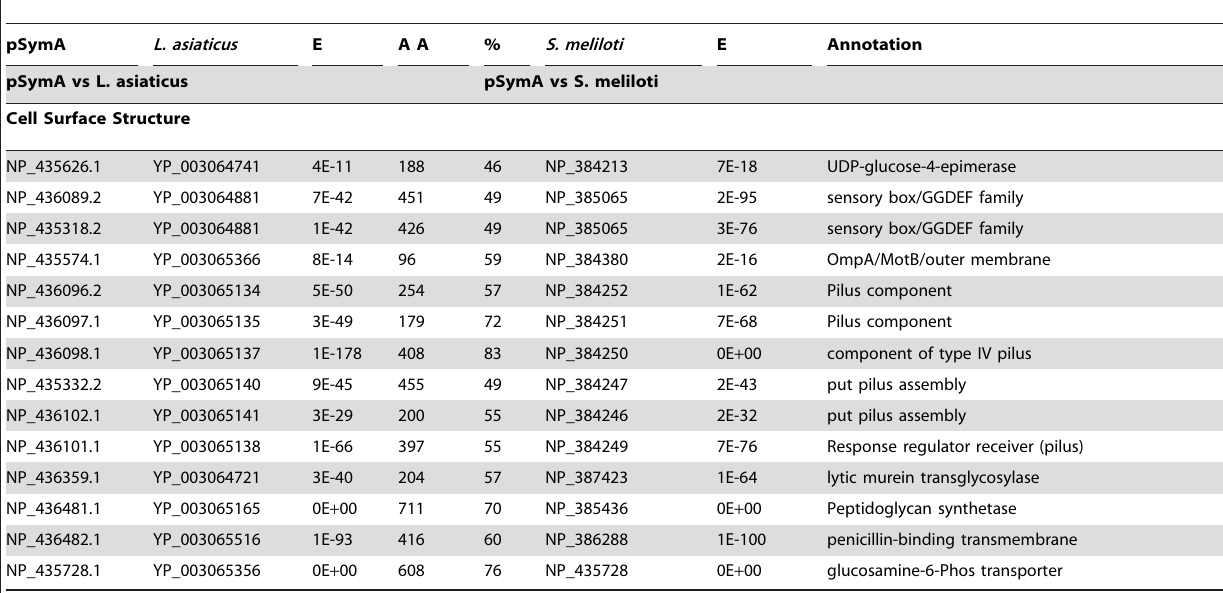
Table 4. Proteins shared between the Sinorhizobium meliloti plasmid pSymA, and the ‘ Ca . Liberibacter asiaticus’ and Sinorhizobium meliloti chromosomes with roles in the modification of cell surface structures.